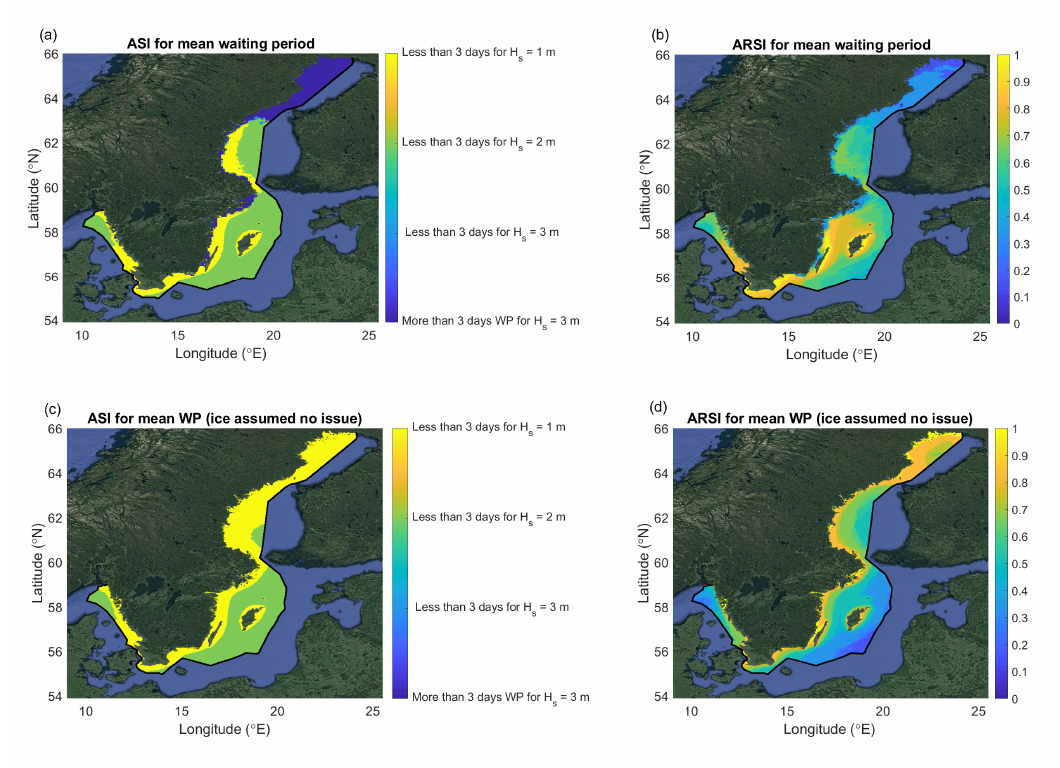
Figure 12. The ASI for mean Waiting Periods (WP) based on considering if the length of mean waiting periods was above or below three days for each of the categories (in ( a , c )) and considering the percentile limits to formulate the ARSI in ( b , d ). The sub-plots ( a , b ) refer to considering the ice seen by the wave model as inhibiting when defining waiting periods, and ( c , d ) are the corresponding figures assuming ice is not inhibiting O&M activities. A value of one indicates the best mean waiting period conditions for all categories considered, and low values imply the presence of longer waiting period for many of the categories